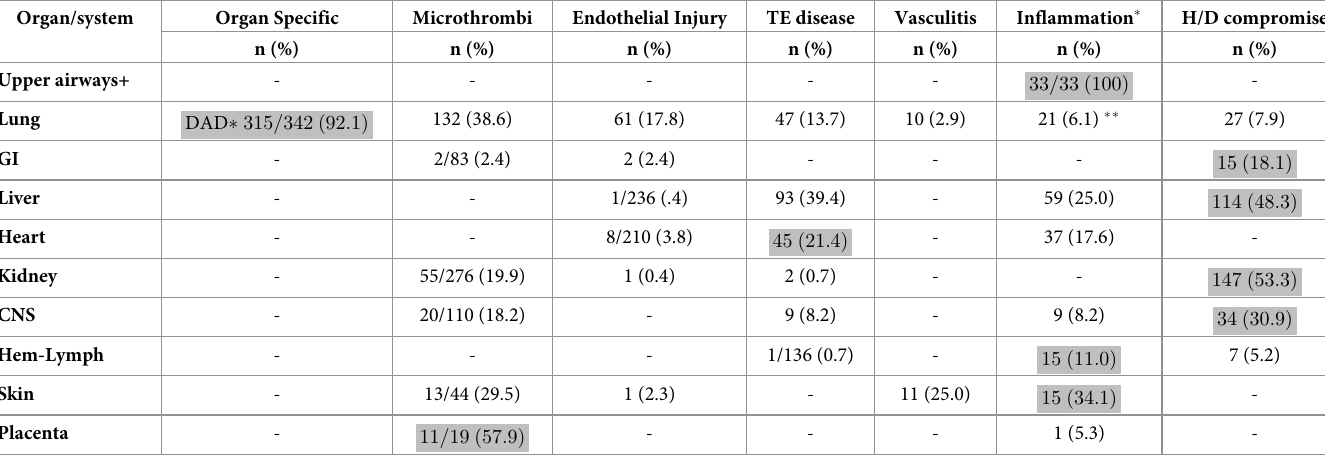
Table 4. Recurrent pathologic findings by